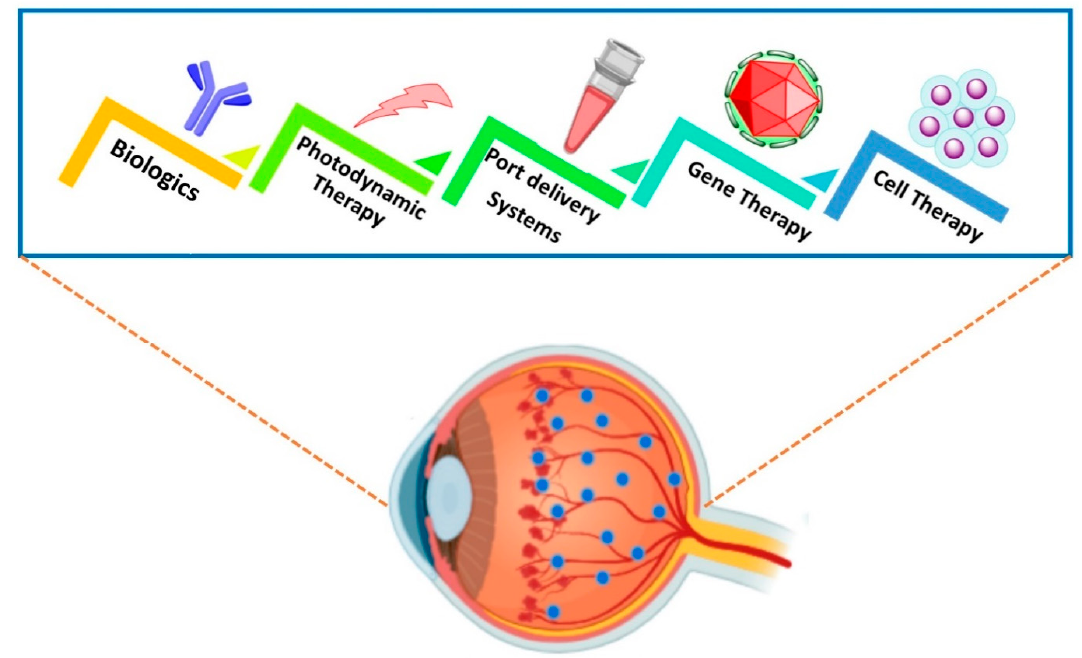
Figure 2. Ocular therapeutics and molecular delivery strategies for neovascular AMD.